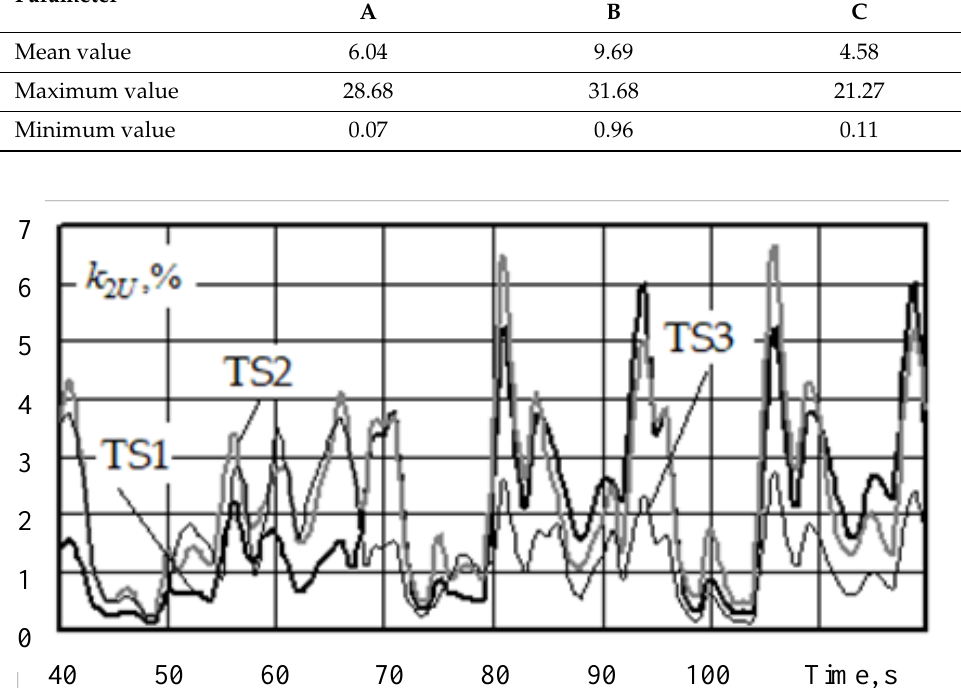
Figure 16. Negative sequence unbalance ratios at 6 kV busbars of the TS. Table 6. The results of calculation of unbalance parameters at 6 kV busbars of the TS.